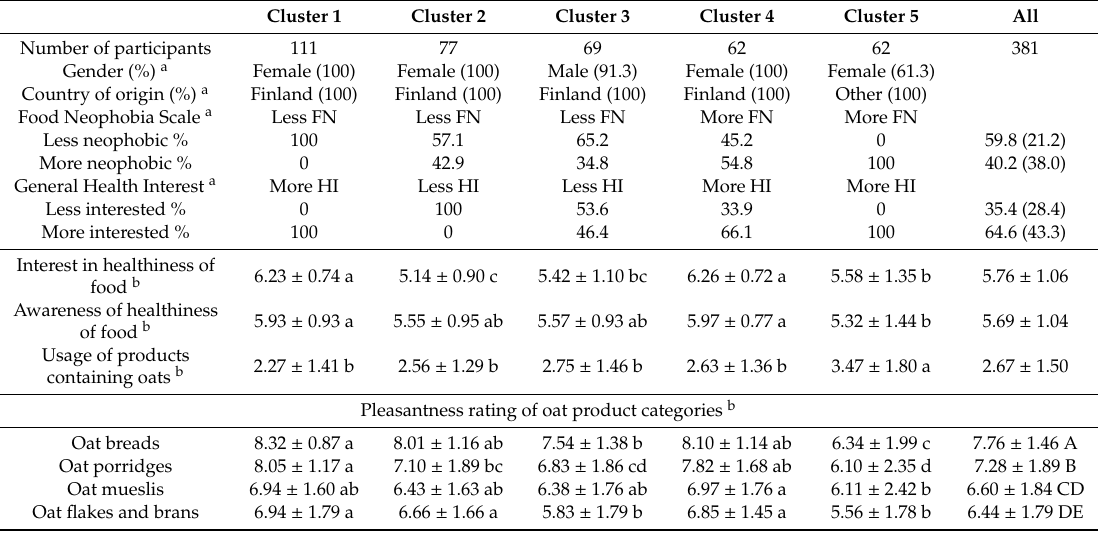
Table 3. Comparison of participant clusters a and the rated liking of oat product categories in the online